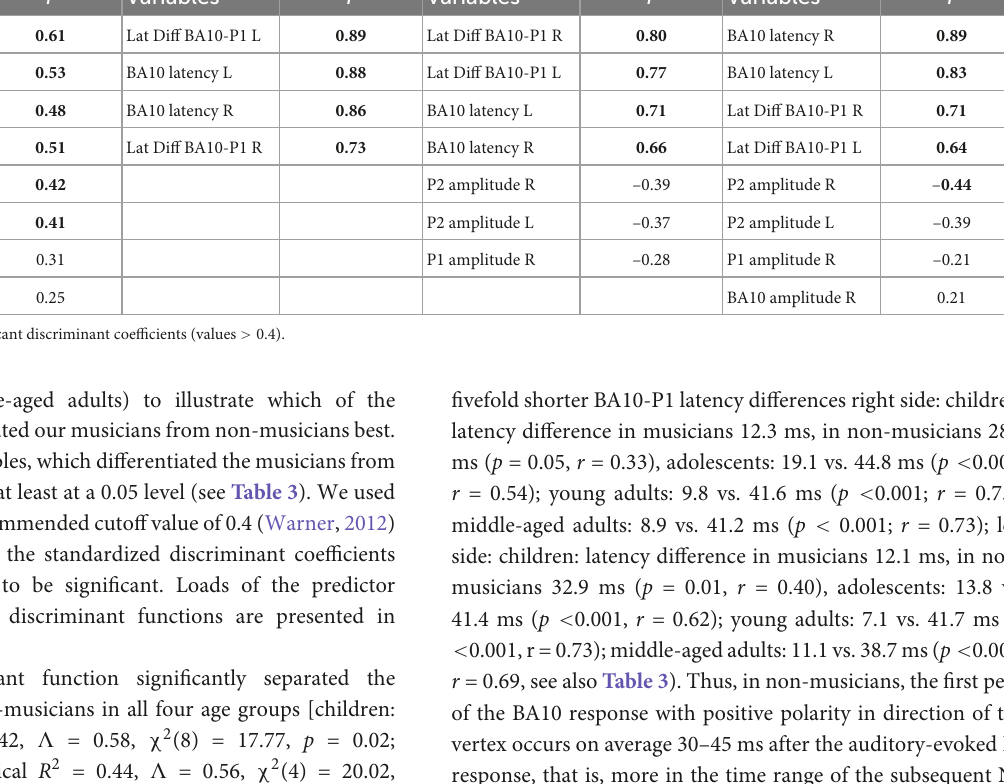
TABLE 4 Predictor variables of the discriminant analyses. Children Adolescents Young adults Middle-aged adults Variables r Variables r Variables r Variables r